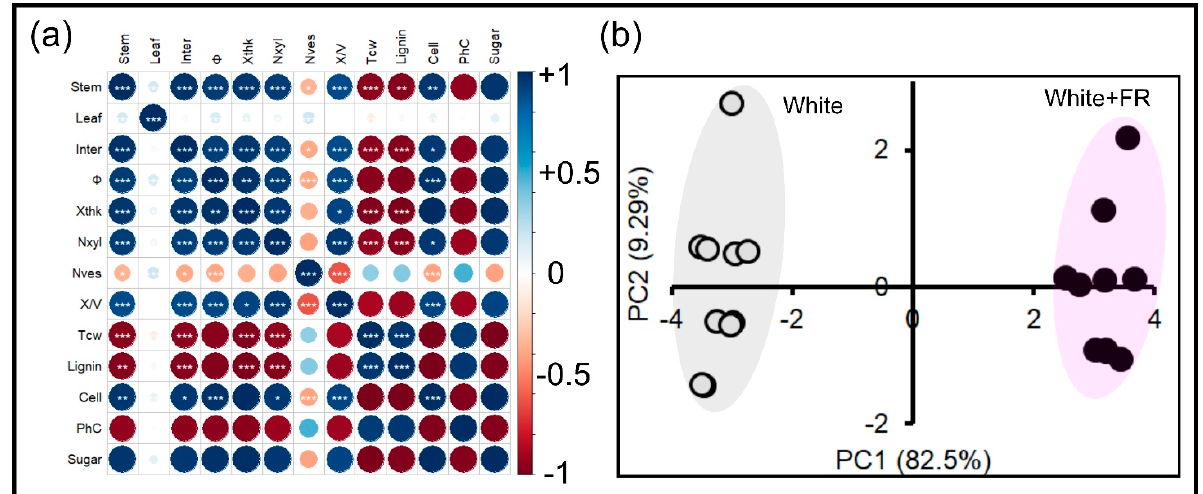
Figure 5. Pearson’s correlation and principal component analysis. ( a ) Measurement of morphological, structural and metabolic components using Pearson’s correlation. ( b ) Principal component analysis of samples from both White and White + FR groups. Asterisks: * p < 0.05, ** p < 0.01, *** p < 0.001. Measured extracts and growth variables include stem number, leaf number, internode, stem diameter ( Φ ), xylem thickness (Xthk), number of xylary fibres (Nxyl), number of vessels (Nves), xylary fibre/vessel ratio (X/V), thickness of cell wall (tcw), lignin concentration (Lignin), cellulose content (Cell), phenolic compounds (PhC) and reducing sugars (Sugar); ( n = 10 ± SE). Open circle represents White and filled circle White + FR light treatment in tobacco plants.